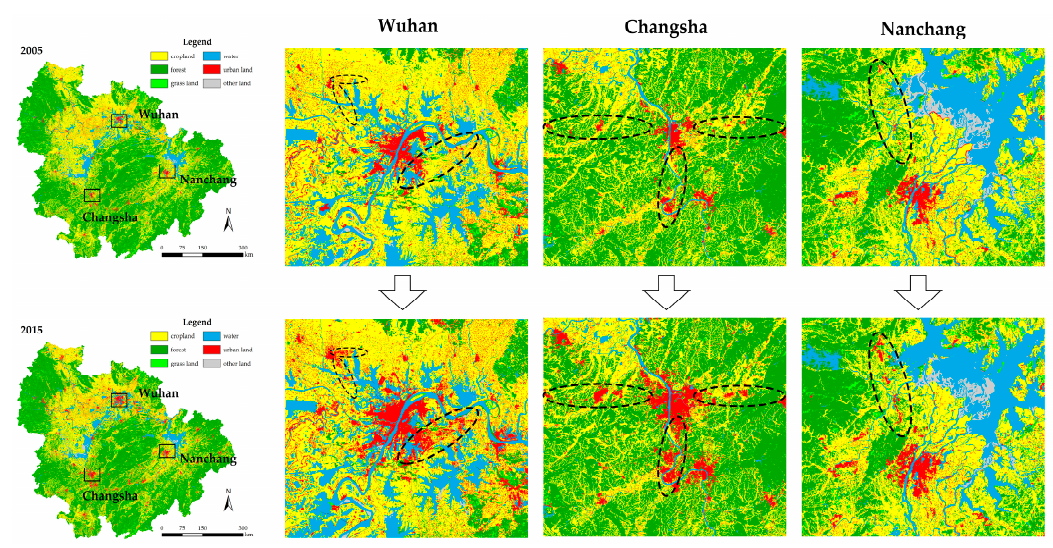
Figure 8. Evolution form of urban land from 2005 to 2015.